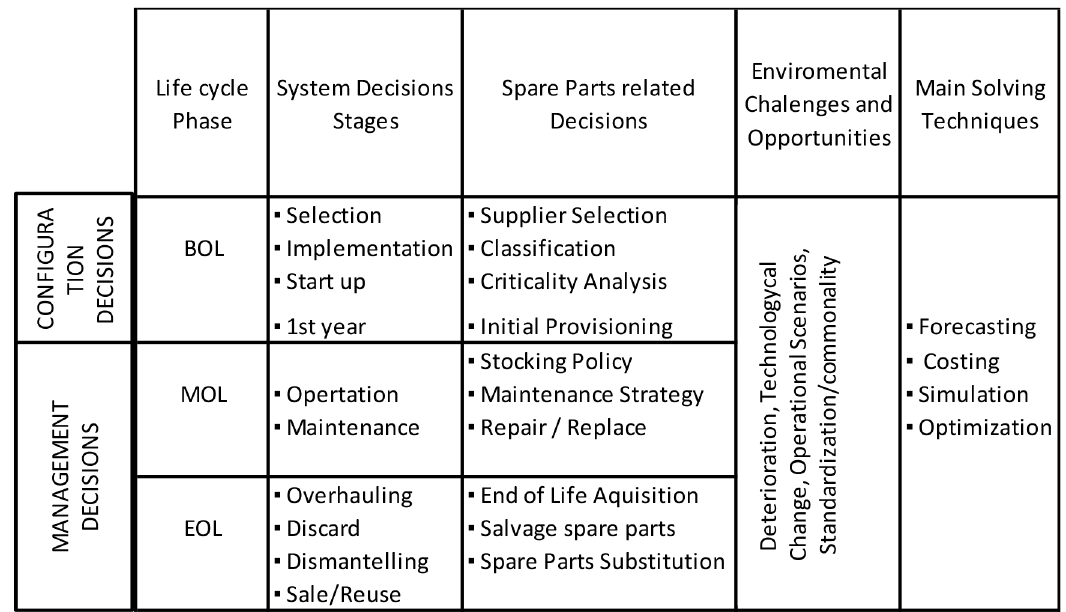
Figure 5. Framework of the relationship between Life Cycle and Spare parts